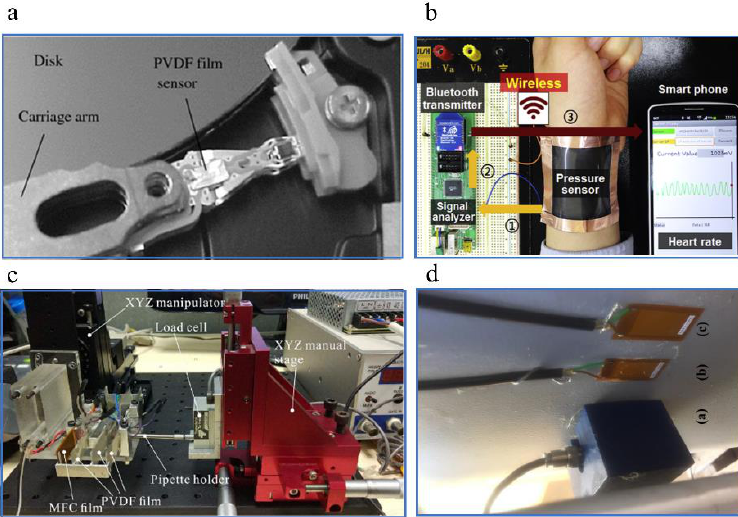
Figure 1. Development of piezoelectric sensor applications. ( a ) A polyvinylidene fluoride (PVDF) film sensor was used in hard disk drivers in 2009. Copyright from Springer Nature. ( b ) A sensor based on ZnO nanoneedles and PVDF hybrid films was used as heart rate monitor in 2016. Copyright from Elsevier. ( c ) A 1-D force sensor based on PVDF and macro-fiber composite (MFC) films was applied to crab egg embryo injection in 2017. Copyright from IEEE. ( d ) Macro-fiber composite (MFC) sensors were presented for measuring acoustic emission signals in 2017. Copyright